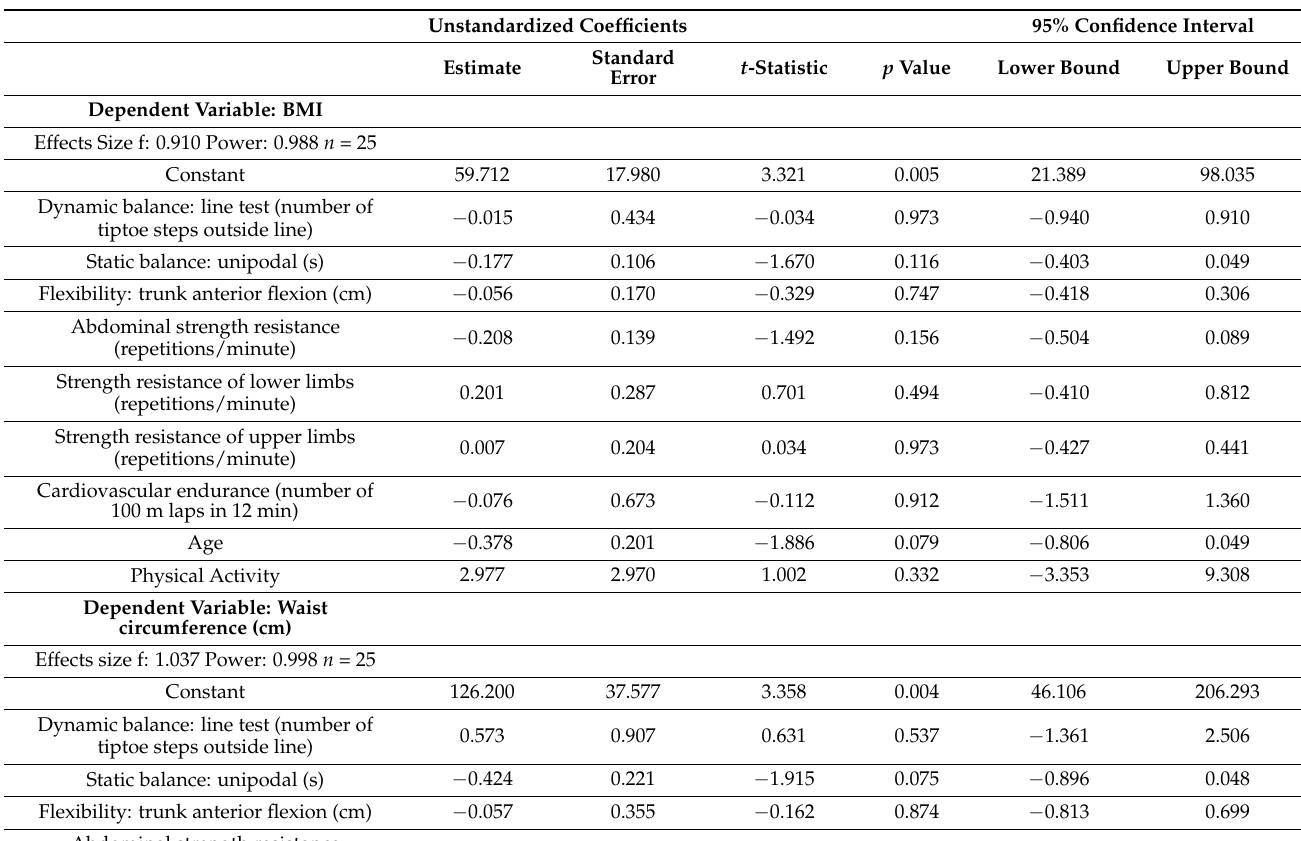
Table 2. General Linear Models parameter